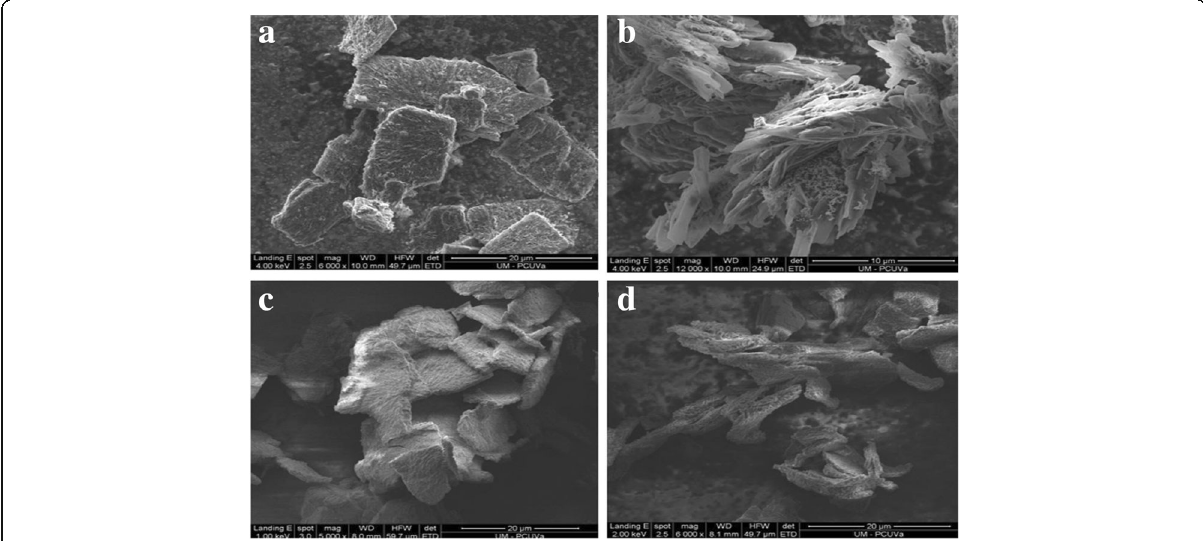
Fig. 7 SEM images of sample B: ( a ) alumina particles coated with carbon nitride; ( b ) detail of the projecting indentations of carbon nitride. It is possible to observe the jaggy shape of the carbon nitride sheets obtained by pyrolysis. SEM images of sample A: ( c ) and ( d ) views of alumina particles coated with carbon nitride. Reproduced from